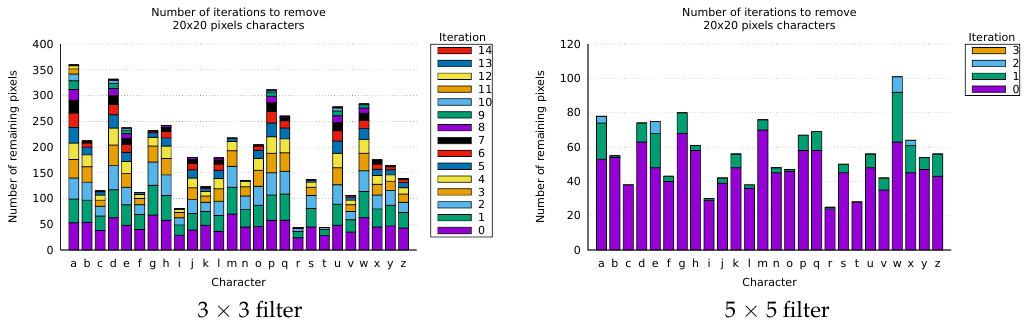
Figure 9. Number of iterations needed to remove 10 pt, occupying approximately 20 × 20 pixels, lowercase characters with a 3 × 3 ( left ) and a 5 × 5 ( right ) filter. The single bar segment indicates the number of pixels removed from the character in each iteration. Iteration 0 indicates the number of initial pixels for each character.